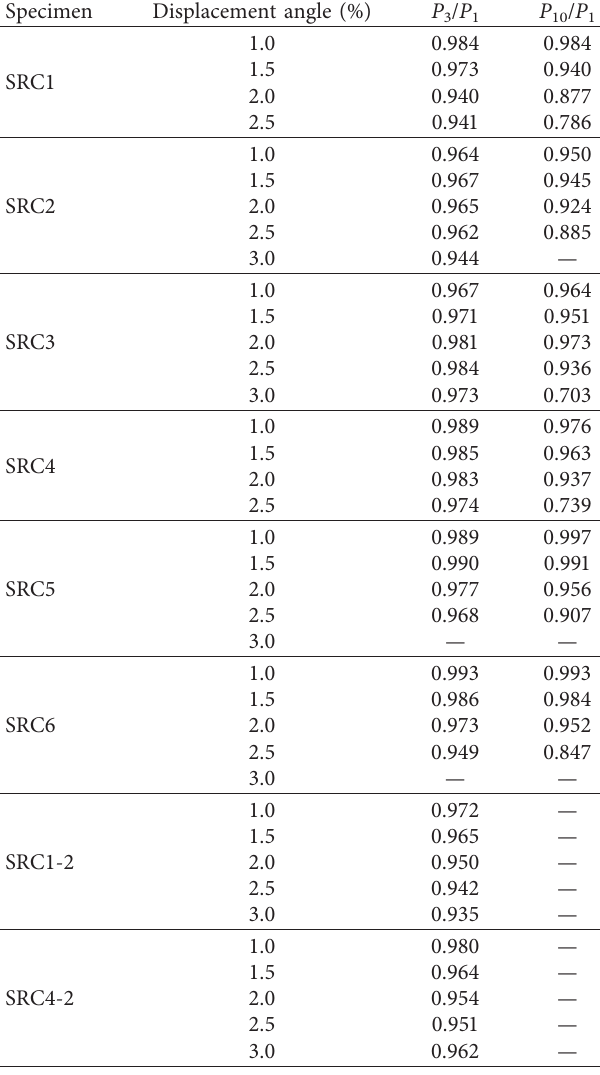
3 / P 1 and P 10 / P 1 of specimens with different displacement